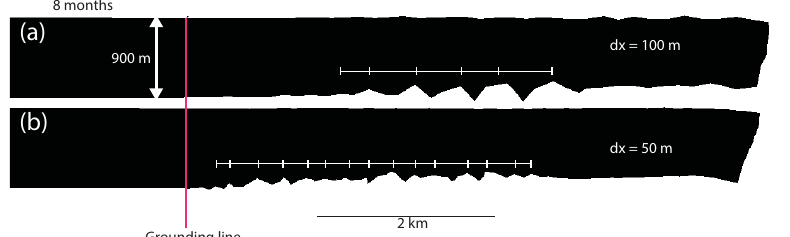
Figure 8. Geometries of the mesh for a resolution of (a) 100m and (b) 50m. The pinch-and-swell features (“boudins”) appear with regularity (white bars) and decreasing size upon mesh refinement. Computational limitations precluded running the simulations at quartered